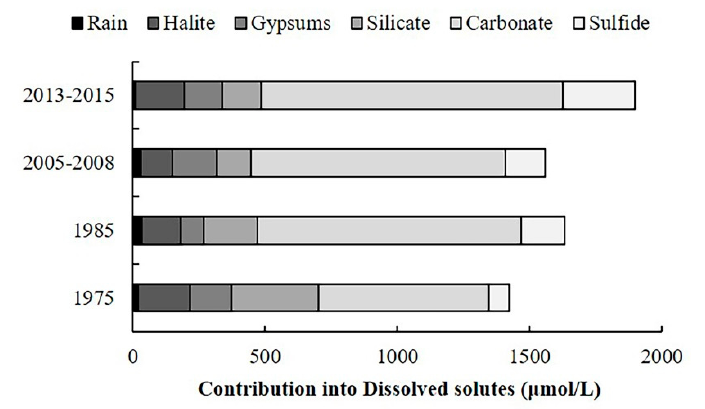
Figure 8. Bar chart showing the contribution of the different natural sources to the riverine solute load for different periods during 1975 to 2015 ( μ mol/L). Table 5. Pearson correlations of major ions and runoff in the basin.